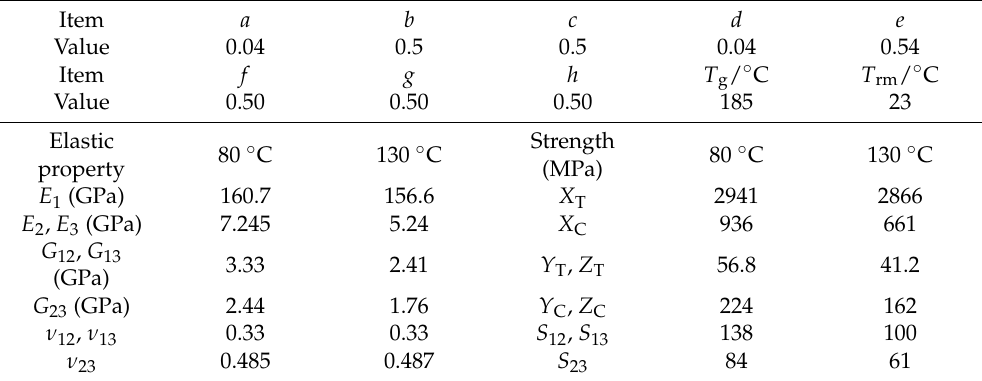
Table 3. Values of the exponents for the engineering constant calculations and the determined mechanical properties of T800/epoxy composites at high